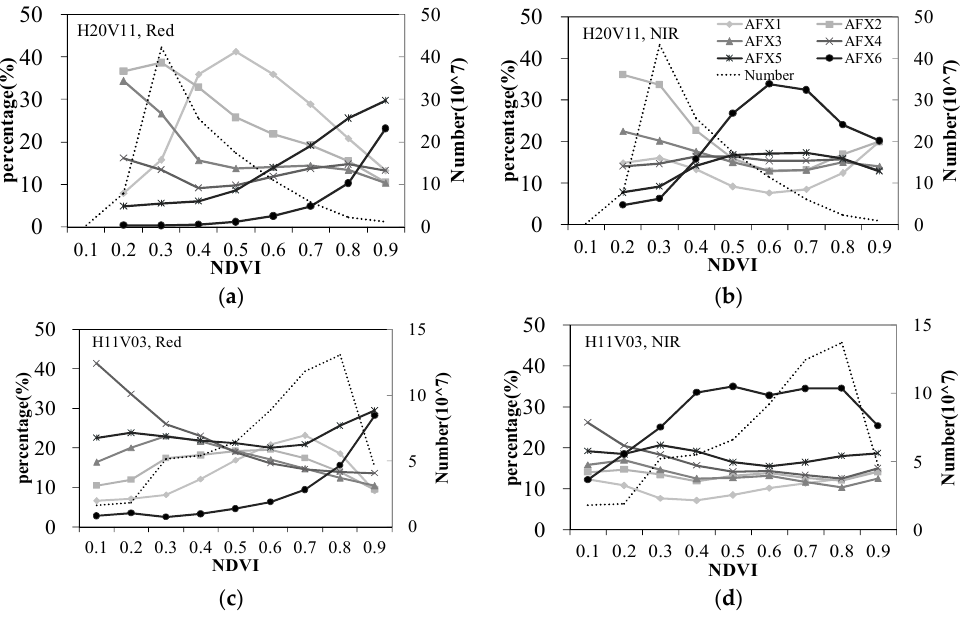
Figure 7. The average percentage of each BRDF archetype class for different NDVI ranges over five years. ( a ) and ( b ) show the results of tile h20v11 in the red and NIR bands. ( c ) and ( d ) show the results of tile h11v03 in the red and NIR bands.